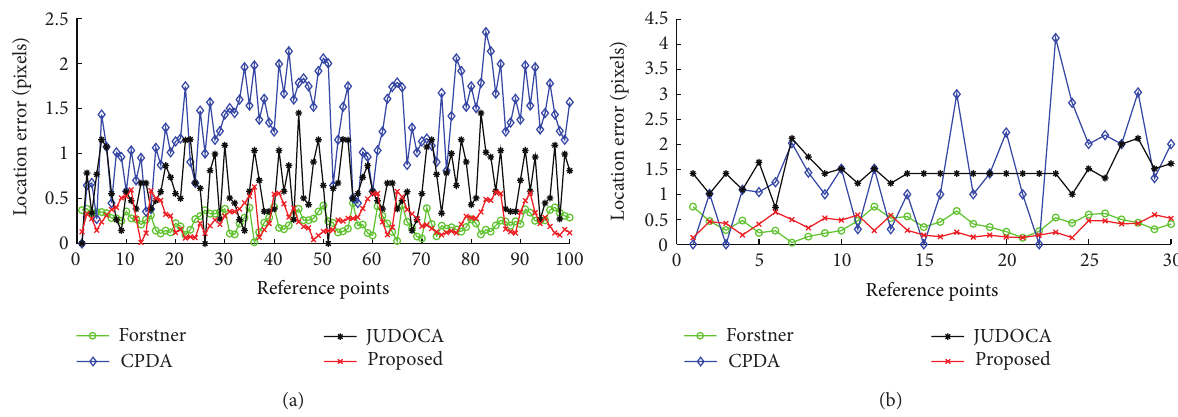
Figure 3: Location accuracy contrast among the Forstner algorithm, CPDA, JUDOCA, and our proposed method for detected junction points. (a) The horizontal axis represents the labeled number of 1 ∼ 100 junction points in Figure 2(a) and the vertical axis describes the location error of the junction points detected by the Forstner algorithm, CPDA, JUDOCA, and our proposed method. (b) The horizontal axis represents the labeled number of 1 ∼ 30 junction points in Figure 2(c) and the vertical axis describes the location error of the junction points detected by the Forstner algorithm, CPDA, JUDOCA, and our proposed method.